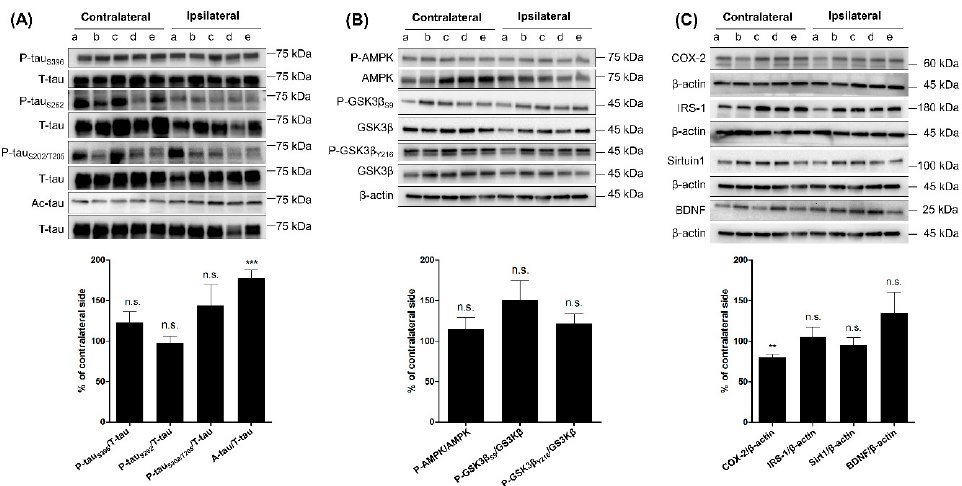
Figure 1. Phosphorylation and acetylation of tau and related proteins in ipsilateral and contralateral cortices in SG at three months after MCAO. Comparison of the levels of protein in ipsilateral cortex with matched contralateral cortex (indicated by the same alphabet) ( n = 9 per group). ( A ) Phosphorylated tau and acetylated tau. ( B ) p-AMPK, p-GSK3 β S9, and p-GSK3 β Y216. ( C ) COX-2, IRS-1, SIRT1, and BDNF. * p < 0.05, ** p < 0.01, and *** p < 0.001 vs. paired contralateral region by one-sample t -test. Vertical bars in graphs indicate standard deviations. T-tau—total tau; p-AMPK—Phosphorylated 5 ′ -AMP—activated protein kinase; p-GSK3 β —phosphorylated glycogen synthase kinase-3 beta; COX-2—Cyclooxygenase 2; IRS-1—Insulin receptor substrate 1; SIRT1—Sirtuin 1; BDNF—Brain-derived neurotrophic factor.